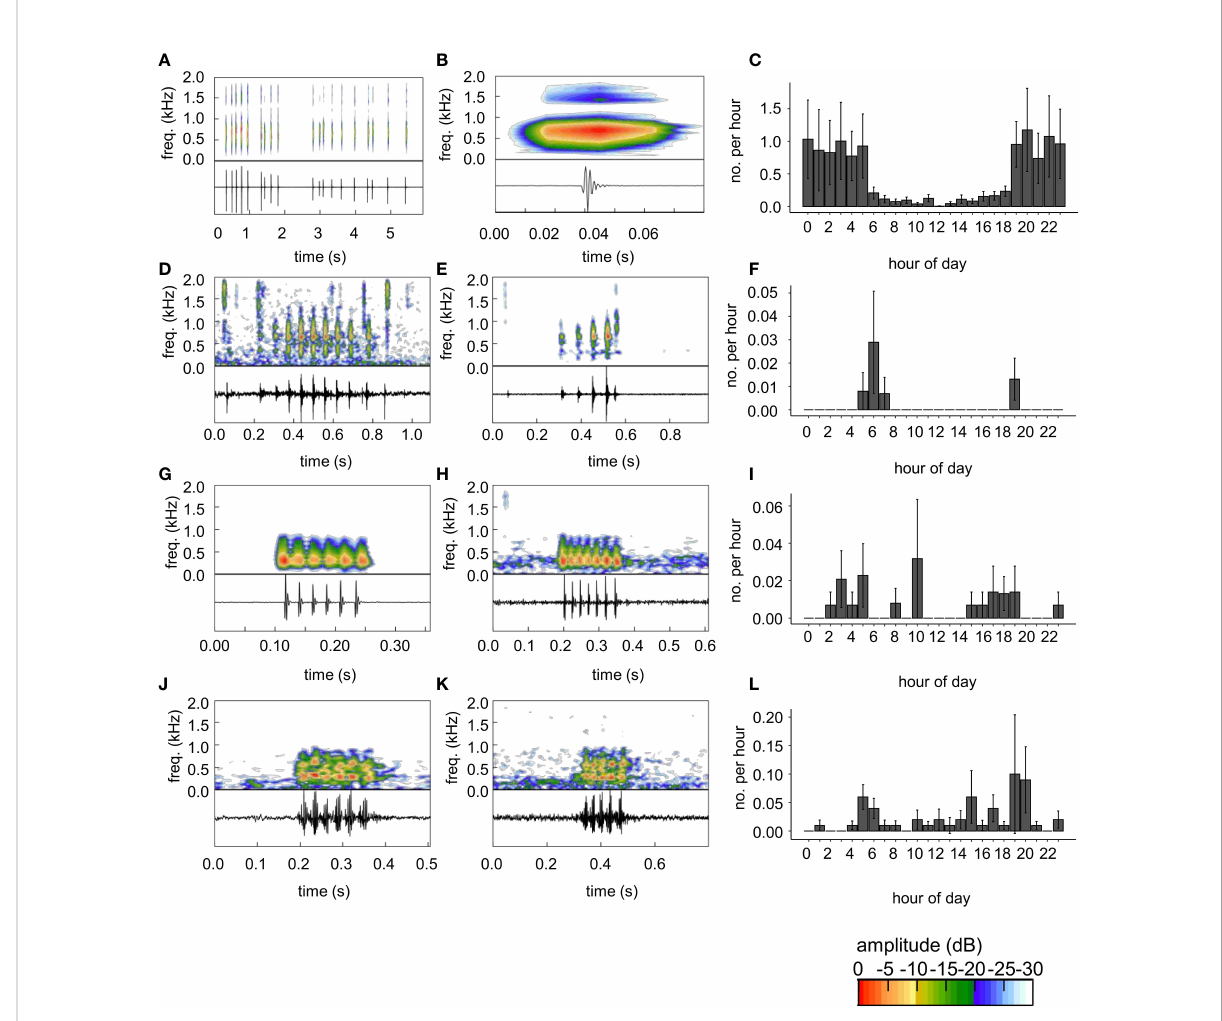
FIGURE 2 Sound types and diel cycles of sounds automatically detected. Oscillograms and spectrograms of sounds are shown for each sound. (A) Pop- sounds and (B) close-up view of a single pop, which was the fi rst of the series shown in (A) . (B) The pop in (B) was used to create template P1 to automatically detect pop sounds. (C) Diel detection rate from template P1. (D, E) Damsel fi sh chirp-like sounds (F) and diel detection rates chirp-like sounds detected by template CL. (G) Grunt-like sound used as template G3. (H) Grunt-like sound detected by template G3. (I) Diel detection rate of sounds using template G3. (J) Grunt-chirp like sound used as template G4. (K) Grunt-chirp like sound detected by template LFP. (L) Diel detection rate of sounds using template G4 as a template. Diel detection rates (C, F, I, L) are the mean ± SE hourly detection rate among all reefs (2017 and 2018) from each template. Note differences in time scales for sound fi gure panels. Color scale bar shows relative amplitude (dB) of frequencies depicted on the